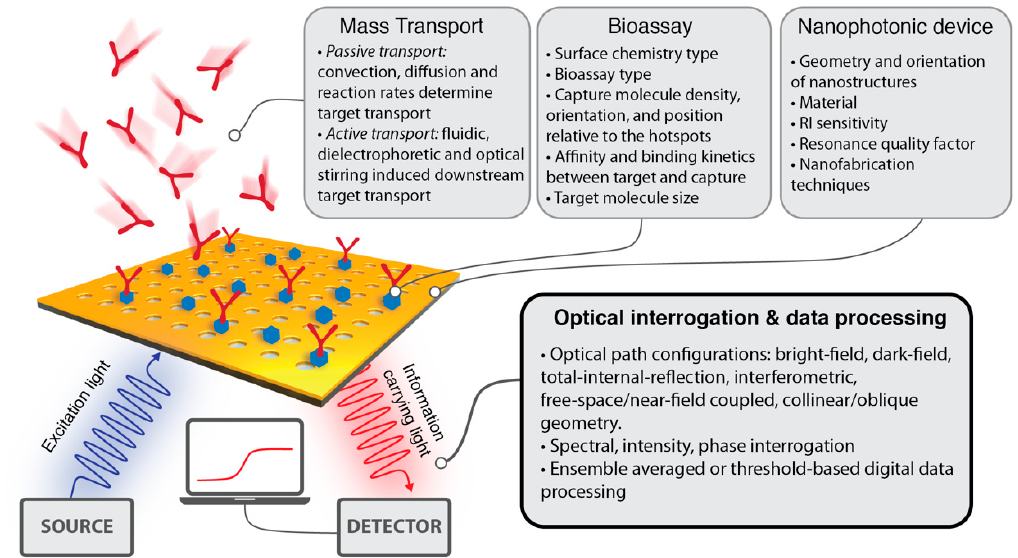
Figure 1. Summary of crucial physical, biochemical, and computational factors affecting the analytical performance of a nanophotonic biochemical sensor.